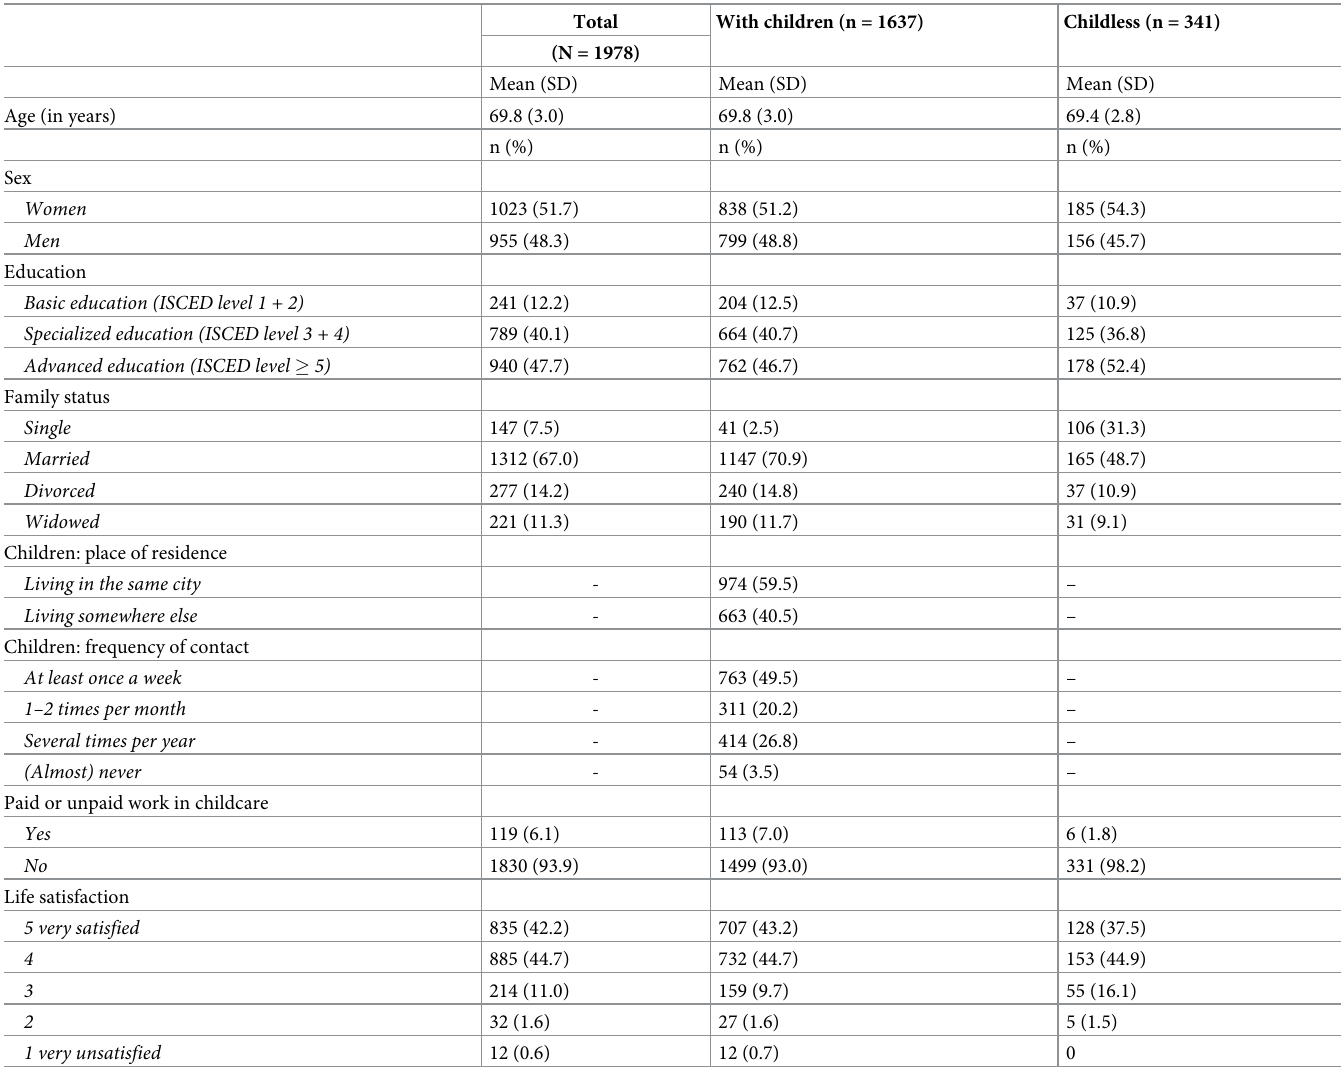
Table 1. Description of the study